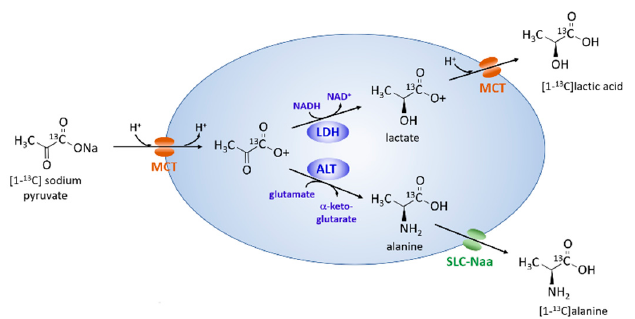
Figure 1. Overview of metabolism of [1- 13 C] pyruvate in cancer cells. MCT = monocarboxylic acid transporters; SLC-Naa = solute carrier protein for neutral amino acids.